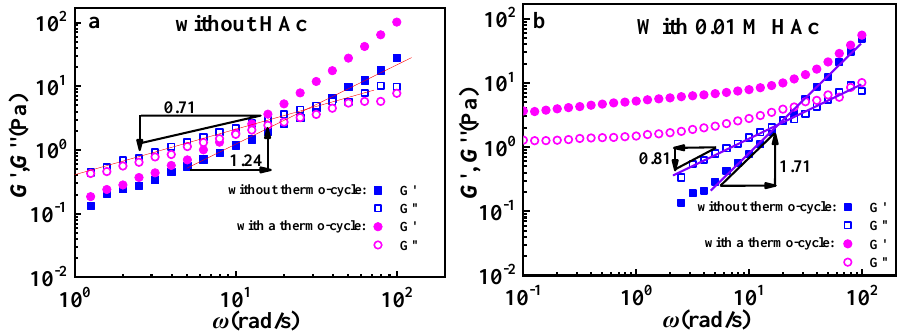
Figure 6. Frequency sweeps of 10 mg / mL GPAM2 solutions ( a ) without HAc and ( b ) with 0.01 M HAc subjected to thermo − cycle (temperature increases from 10 ◦ C to 60 ◦ C, then decreases to 10 ◦ C, ramp rate: 5 ◦ C / min) at 10 ◦